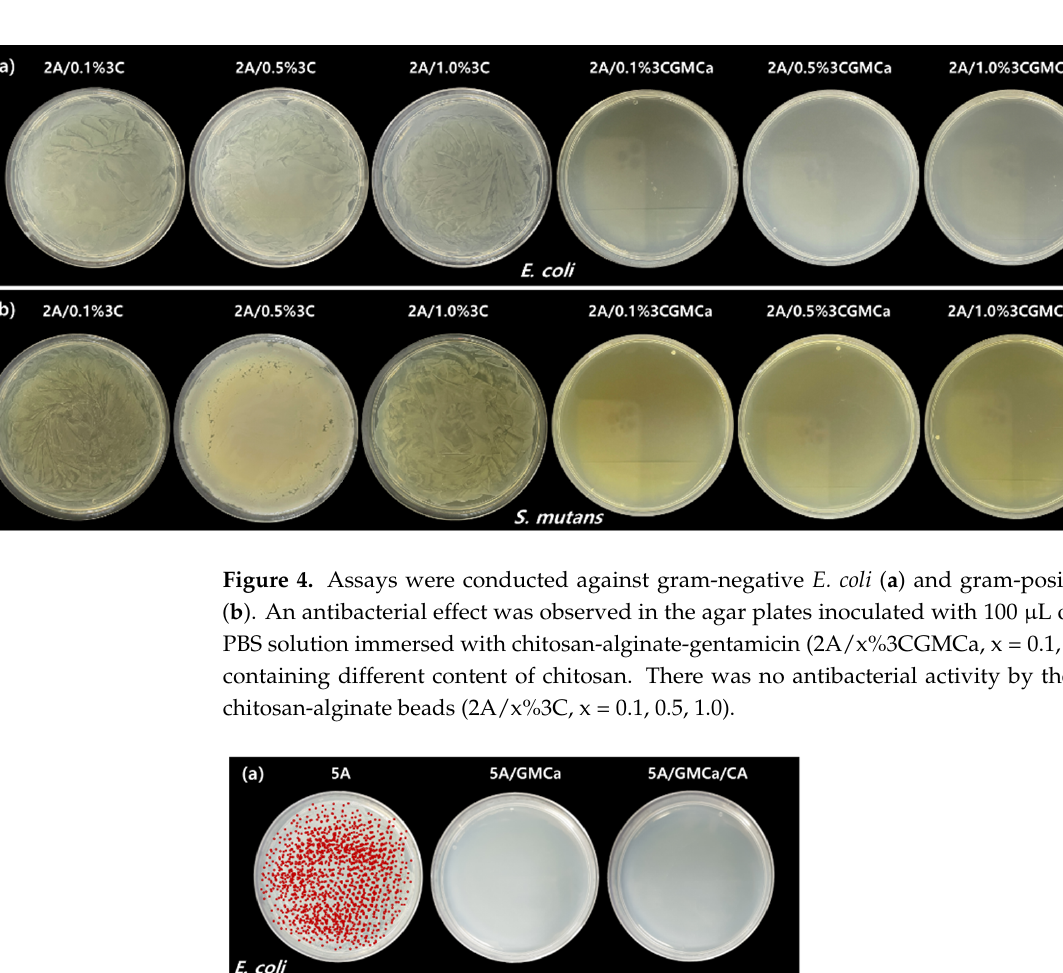
Figure 5. Optical photos of antibacterials effect of 5A, 5A/GMCa, and 5A/GMCa/CA ( a ) against E. coli and ( b ) against S. mutans . An antibacterial effect was observed in the agar plates inoculated with 100 uL PBS solution containing gentamicin-loaded alginate (5A/GMCa) beads and gentamicin- loaded alginate crosslinked with citric acid (5A/GMCa/CA) beads while there was no antibacterial activity by the extract from alginate-only beads (5A) as demonstrated by the appearance of numerous colony formations on the agar plates (marked with red circles).